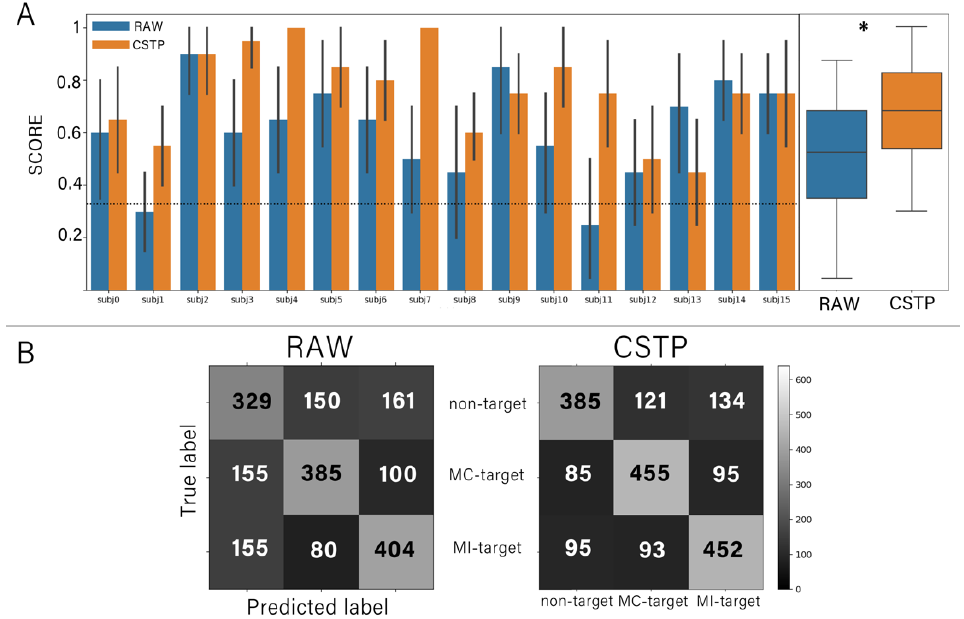
Figure 4. ( A ) Offline performance of each subject averaged over all cross-validation trials. The bars denote the mean; the error strokes denote the standard deviation. Asterisk (*) indicates significant difference in accuracy score between two feature extraction approaches ( p = 0.018). The dashed line indicates the chance level. ( B ) Confusion matrices for each feature extraction approach, where the grayscale intensity and numbers denote the quantity of true positive, false positive, false negative and true negative classification cases.